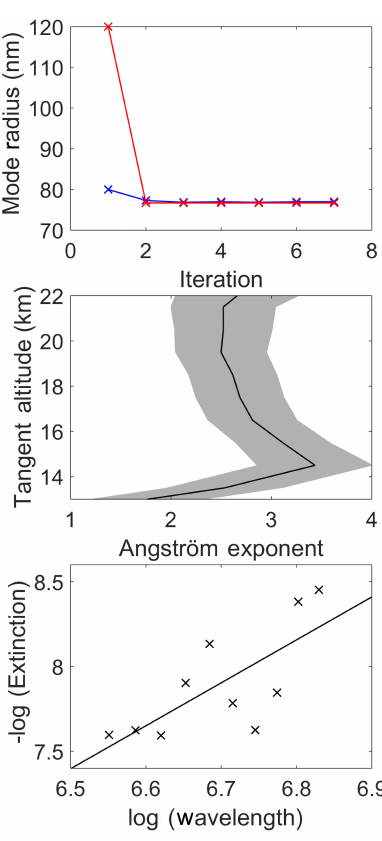
Figure 13. The top panel shows the convergence of two sample par- ticle size retrievals; blue and red represent an initial state of 0.08 and 0.12µm mode radius respectively. Both initial states converge to the same value over approximately three iterations in the particle size retrieval method. The middle panel shows the final Angström ex- ponents determined from images 204–216. The shading represents the error associated with the least squares fit. The bottom panel shows a typical least squares fit of the retrieved extinction values over wavelength to determine the Angström exponent at model al- titude of